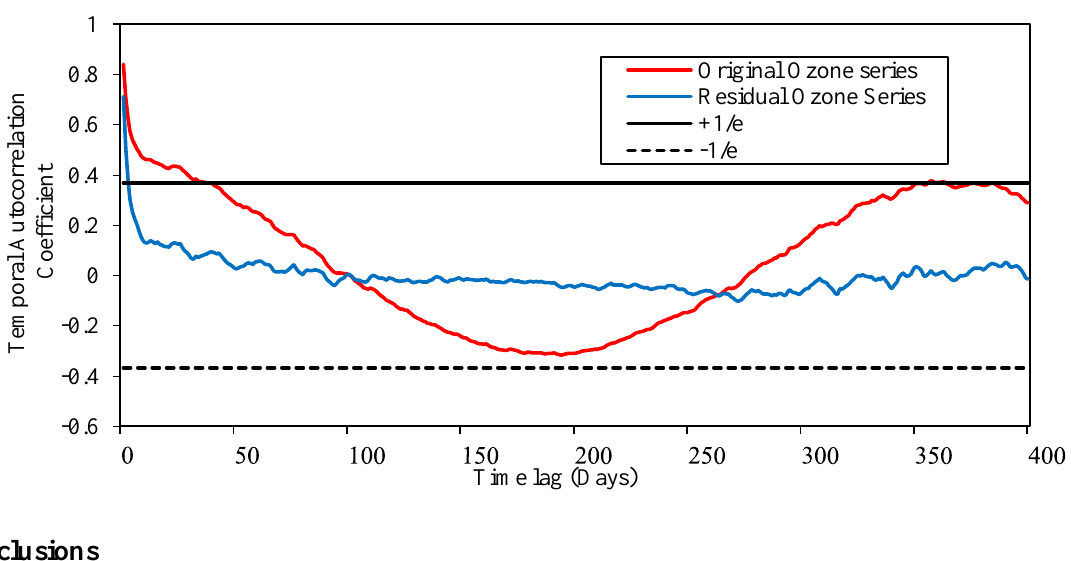
Figure 9. Autocorrelation coefficients of the daily TOC series and residual series with a time lag of up to 400 days (latitudinal band of